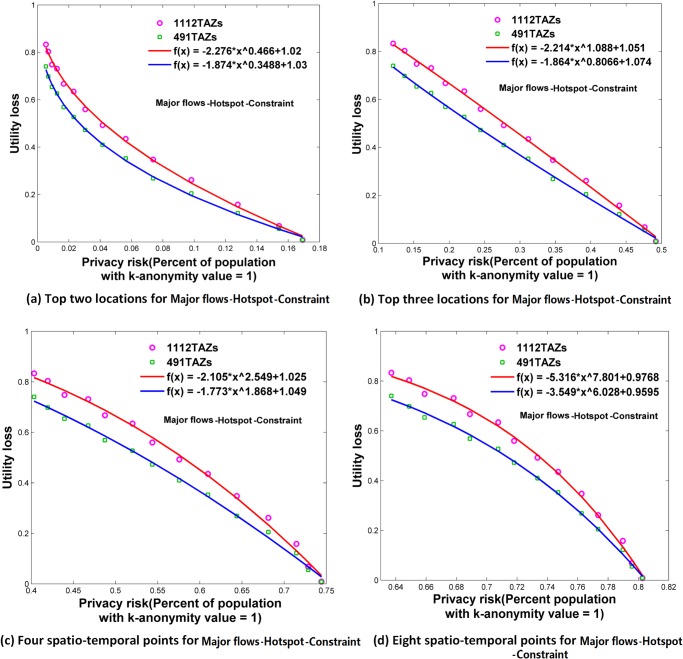
Relationships between privacy risk and data utility using Major flows-Hotspot-Constraint.(a) Top two locations. (b) Top three locations. (c) Four spatio-temporal points. (d) Eight spatio-temporal points.